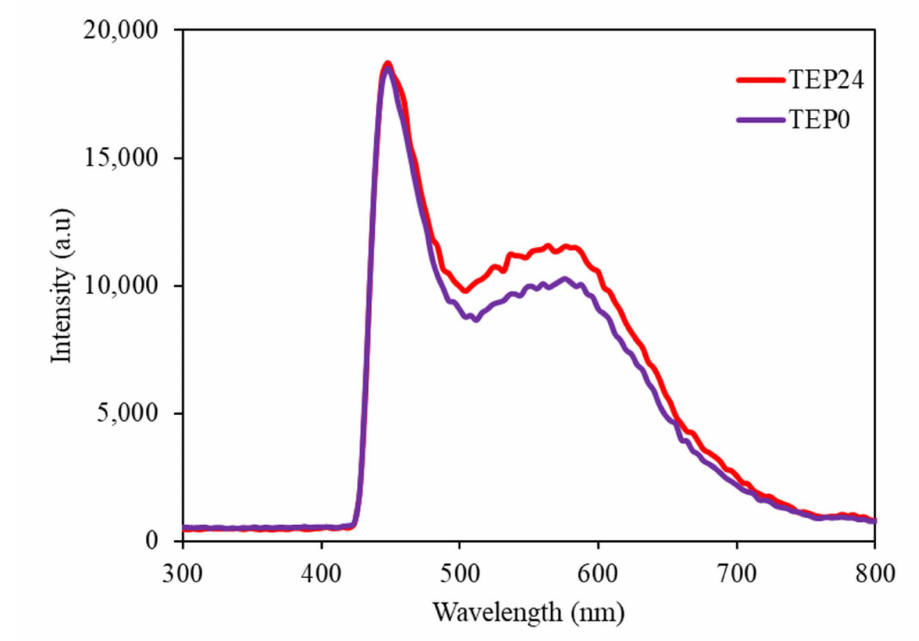
Figure 11. Photoluminescence (PL) spectroscopy of TEP0 and TEP24.